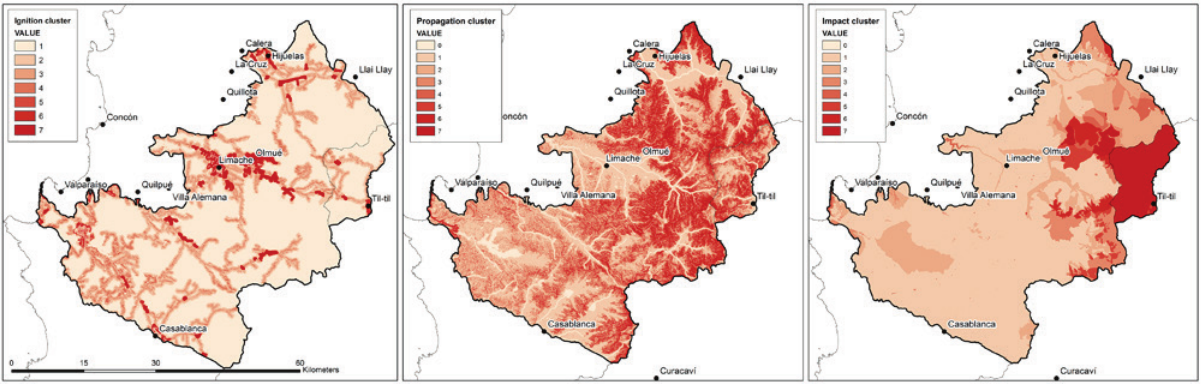
Figure 4. Th ree cluster maps